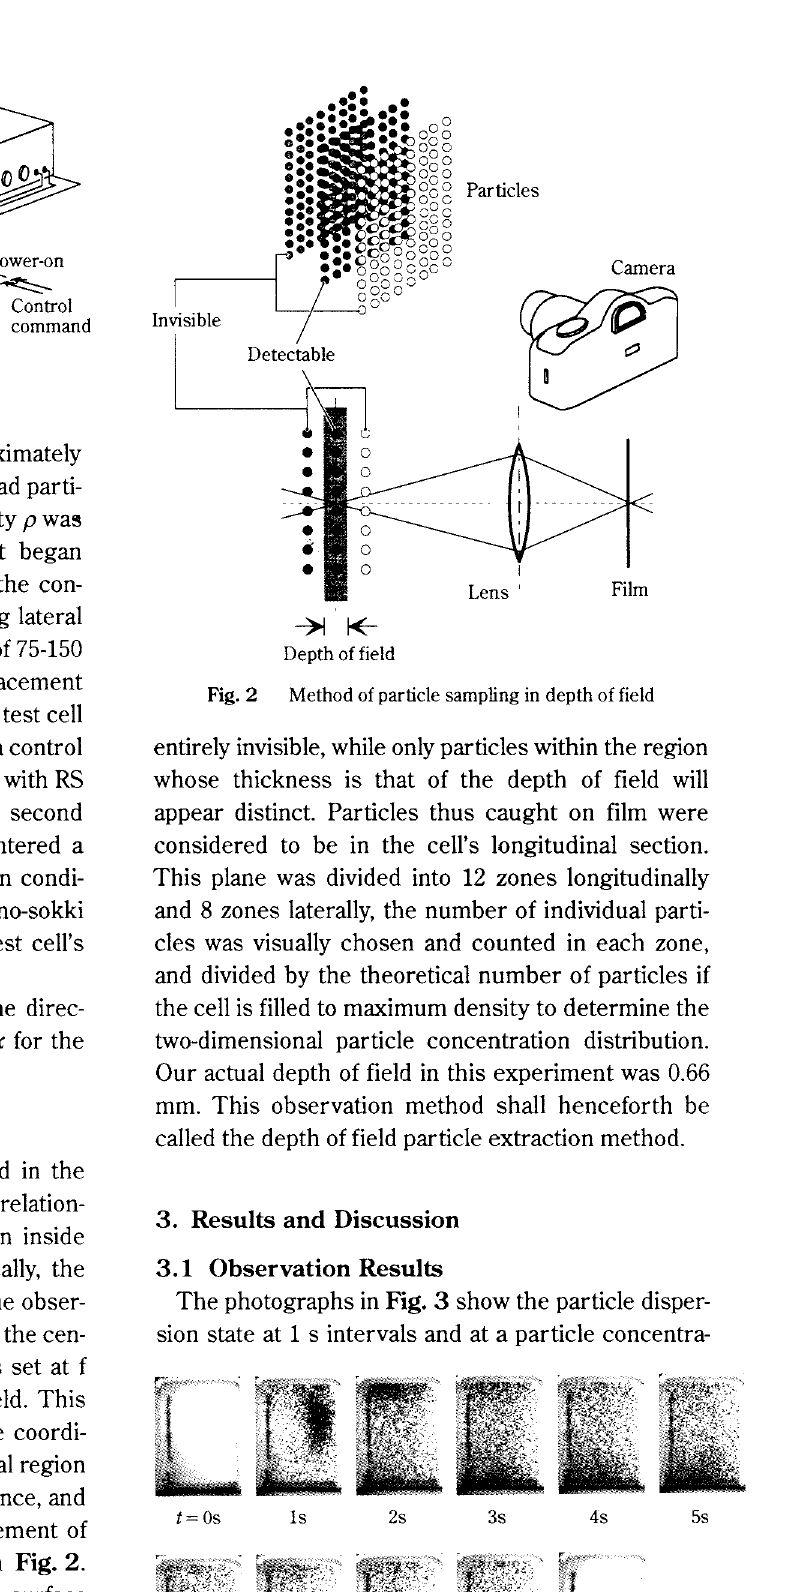
Photographs of particle